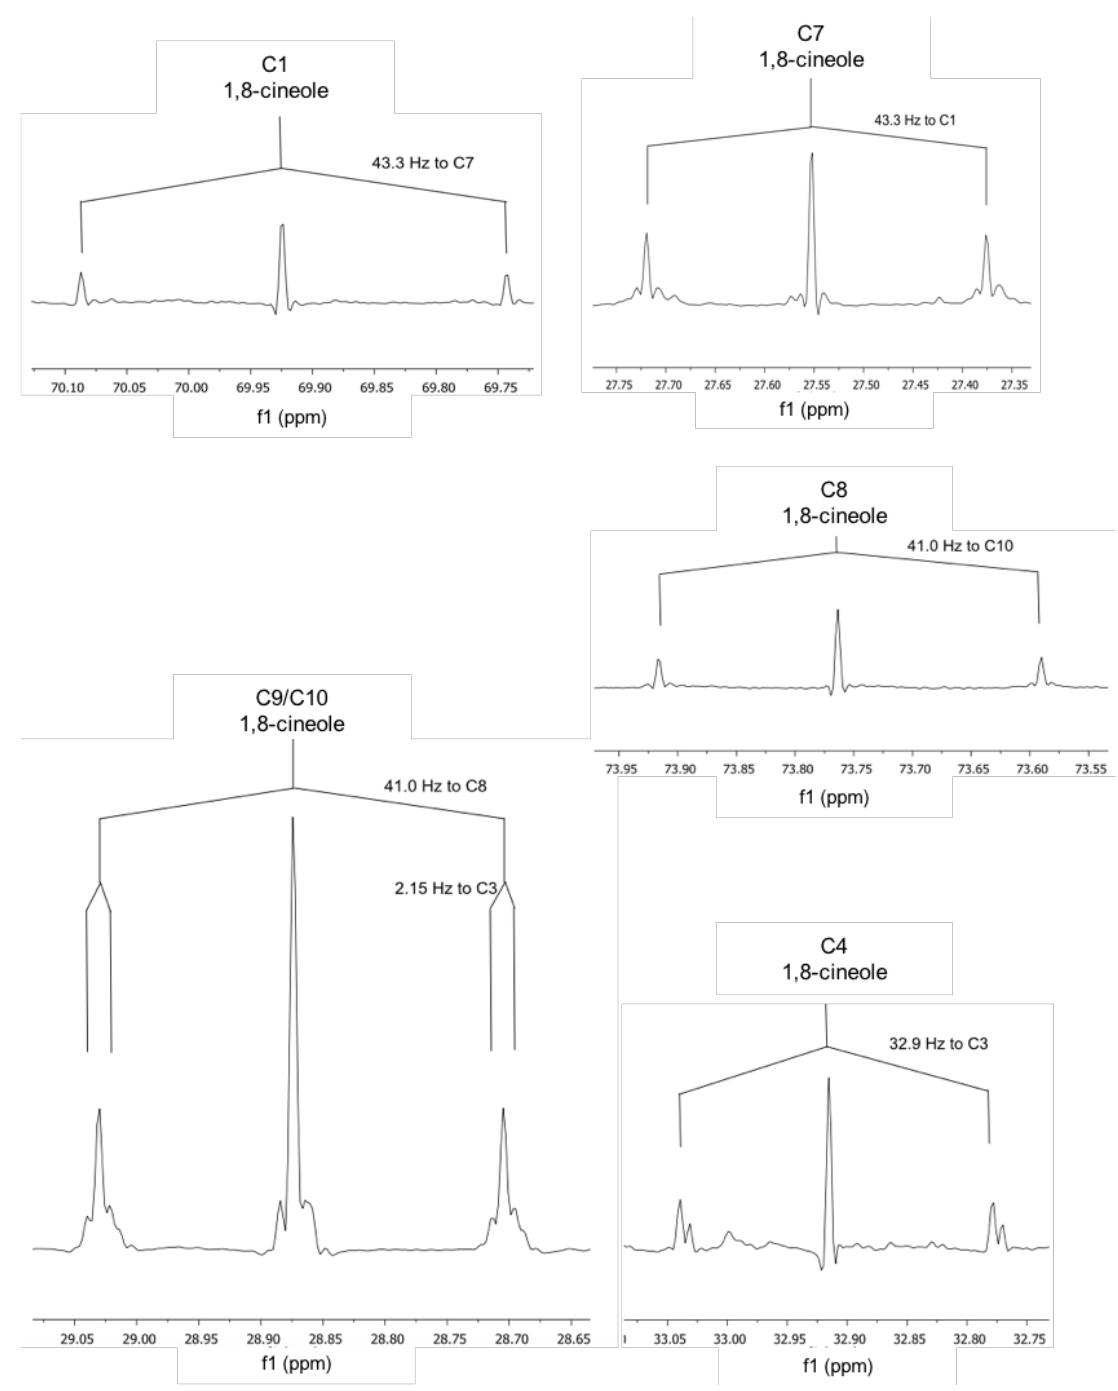
Figure 7. 13 C NMR 1,8-cineole signals; chloroform-d leaf essential oil extract from spike lavender after incorporation of 13 CO 2 (pulse 5.2 h, chase 192 h).